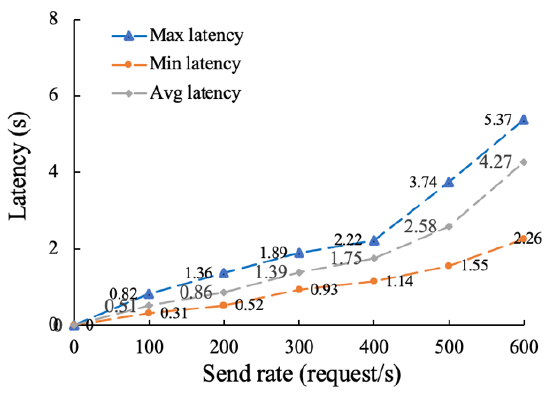
Figure 11. Latency testing of the traceability function.